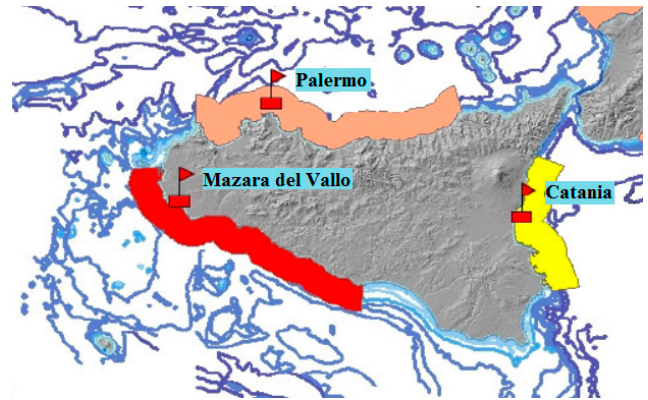
Figure 7. Measuring stations in Sicily.